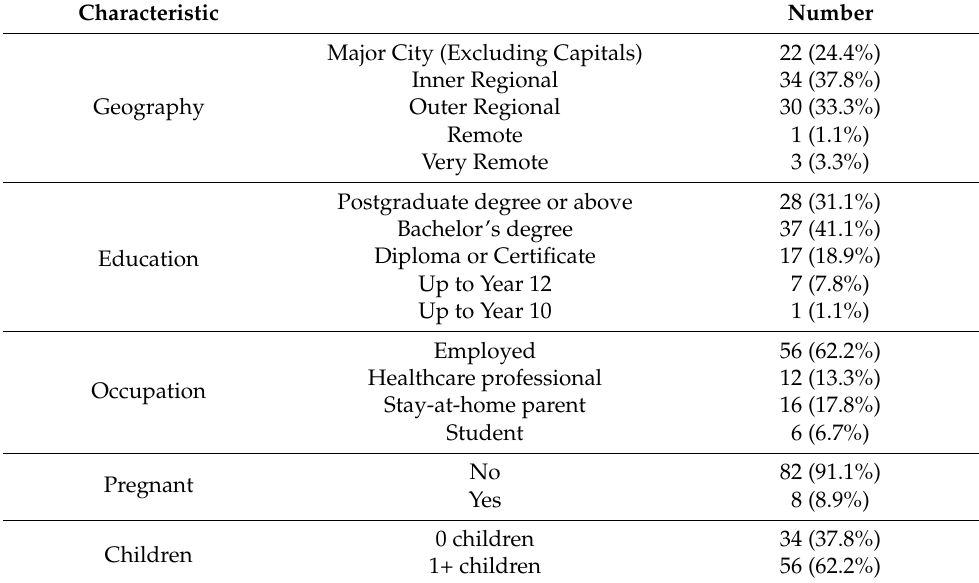
Table 1. Sociodemographic characteristics of the questionnaire